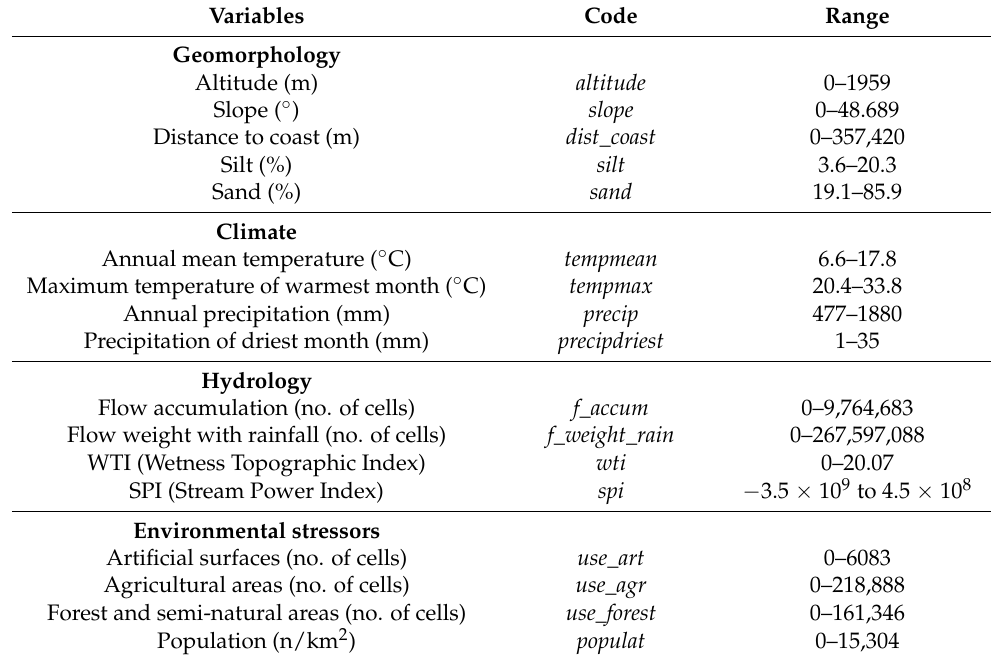
Table 1. Variables initially selected to model threespine stickleback’s